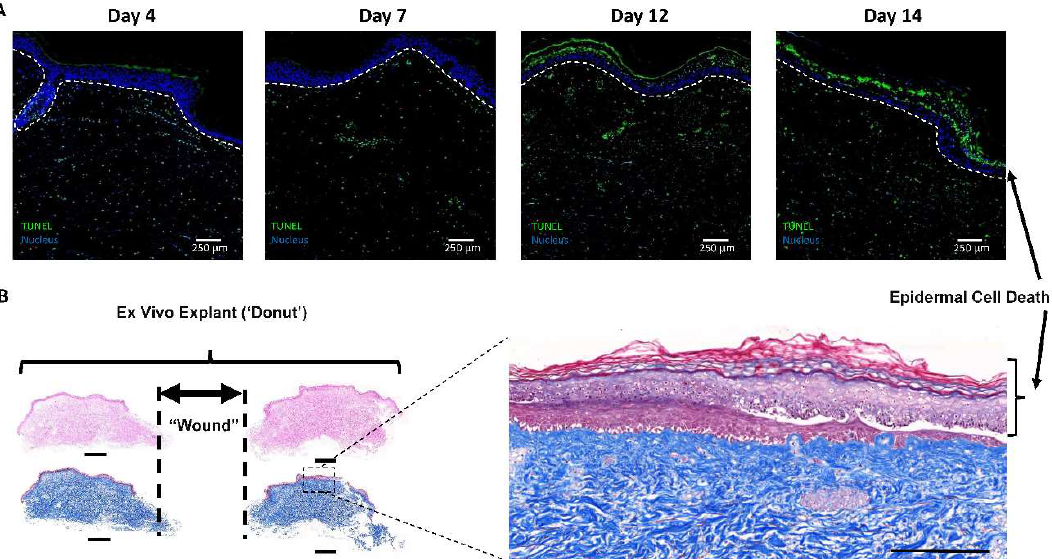
Figure 1. Tissue viability in the 4 mm punch wound pilot study. ( A ) Ex vivo untreated control samples were harvested at the stated time points, sectioned, and stained for cellular death by TUNEL (green staining). A significant increase in terminal deoxynucleotidyl transferase dUTP nick-end labeling (TUNEL) staining was evident in the epidermis over time (white dotted line designates the bottom of the epidermis). ( B ) Representative hematoxylin and eosin (H&E) (left side upper 2 sections) and Masson’s Trichrome (MTC, left side lower 2 sections) staining of day 14 untreated explant cut directly through the center of the donut resulting in 2 pieces with the edges of the wound represented by dotted lines. Scale bars equal 1 mm. Enlarged MTC image to the right indicates similar epidermal cytotoxicity that is observed in the TUNEL staining above. Scale bar equals 250 µm.